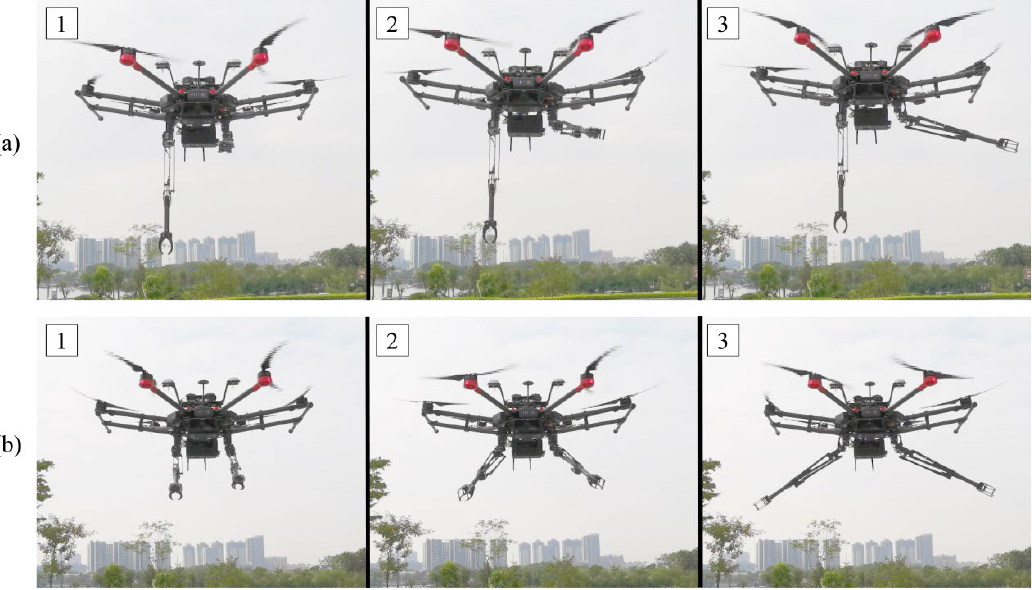
Figure 16. Image sequence of hovering manipulation stability test in outdoor: ( a ) reciprocating swing of single-arm; ( b ) reciprocating swing of dual-arm.